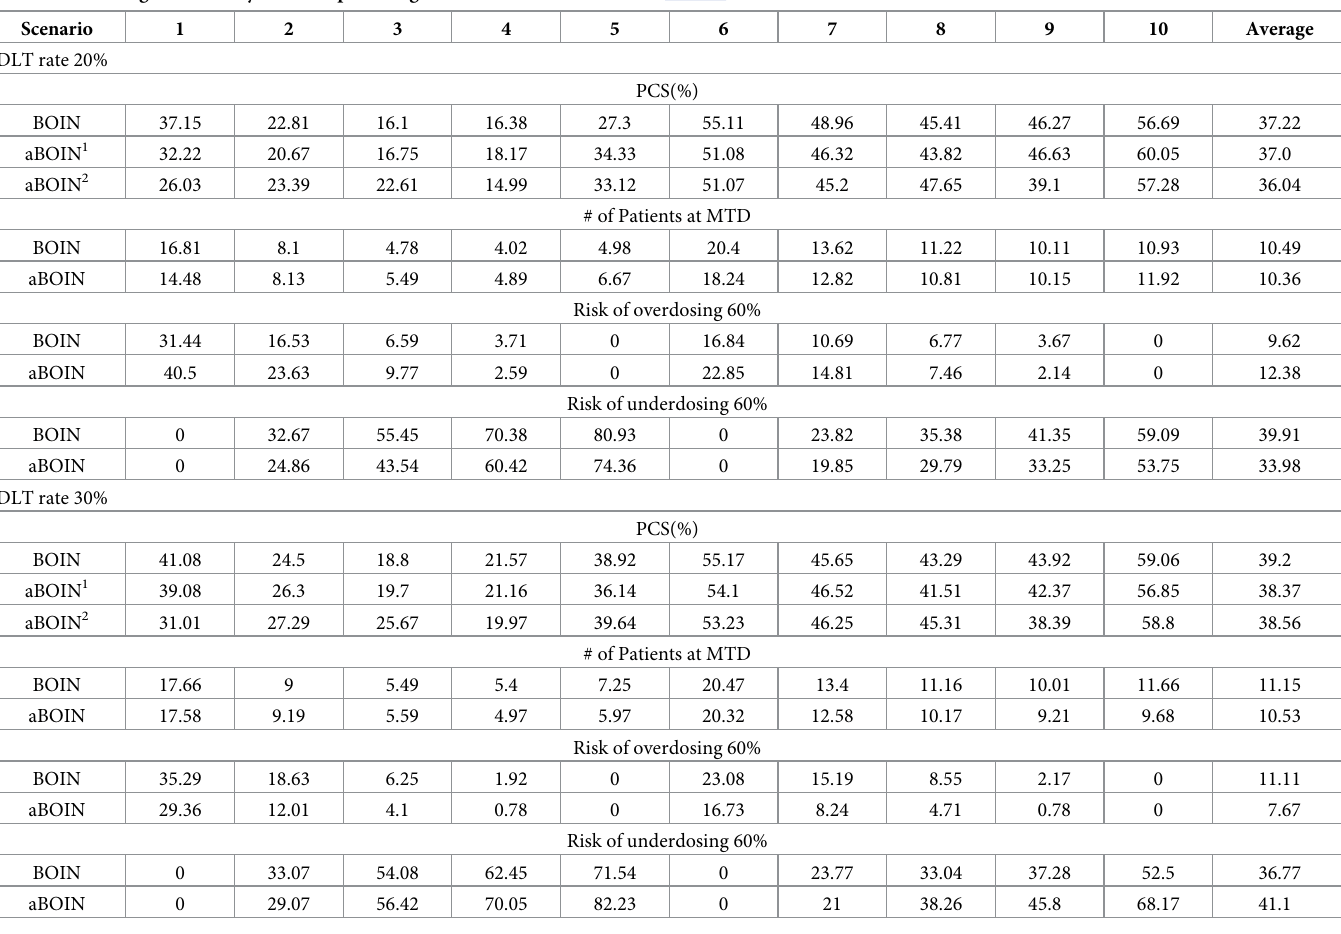
Table 3. Percentage of correctly selection percentage of MTD for ten scenarios in Table